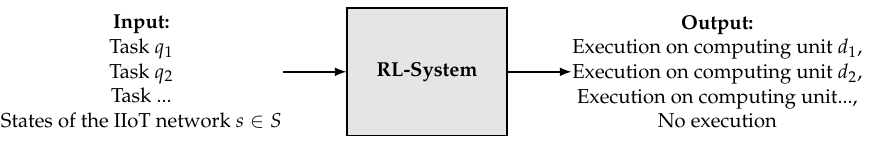
Figure 4. Abstraction of the problem